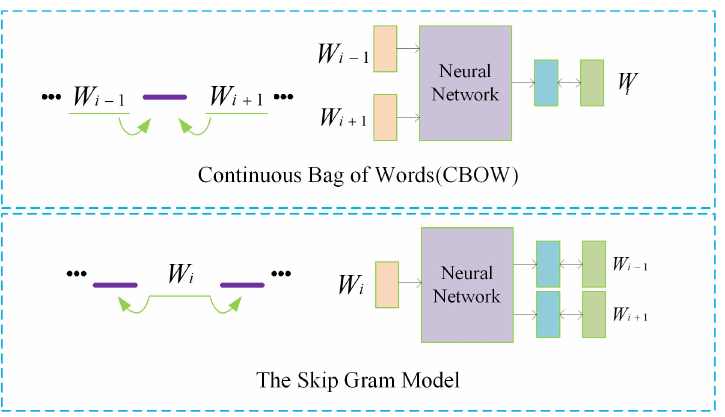
Figure 5. Two models for